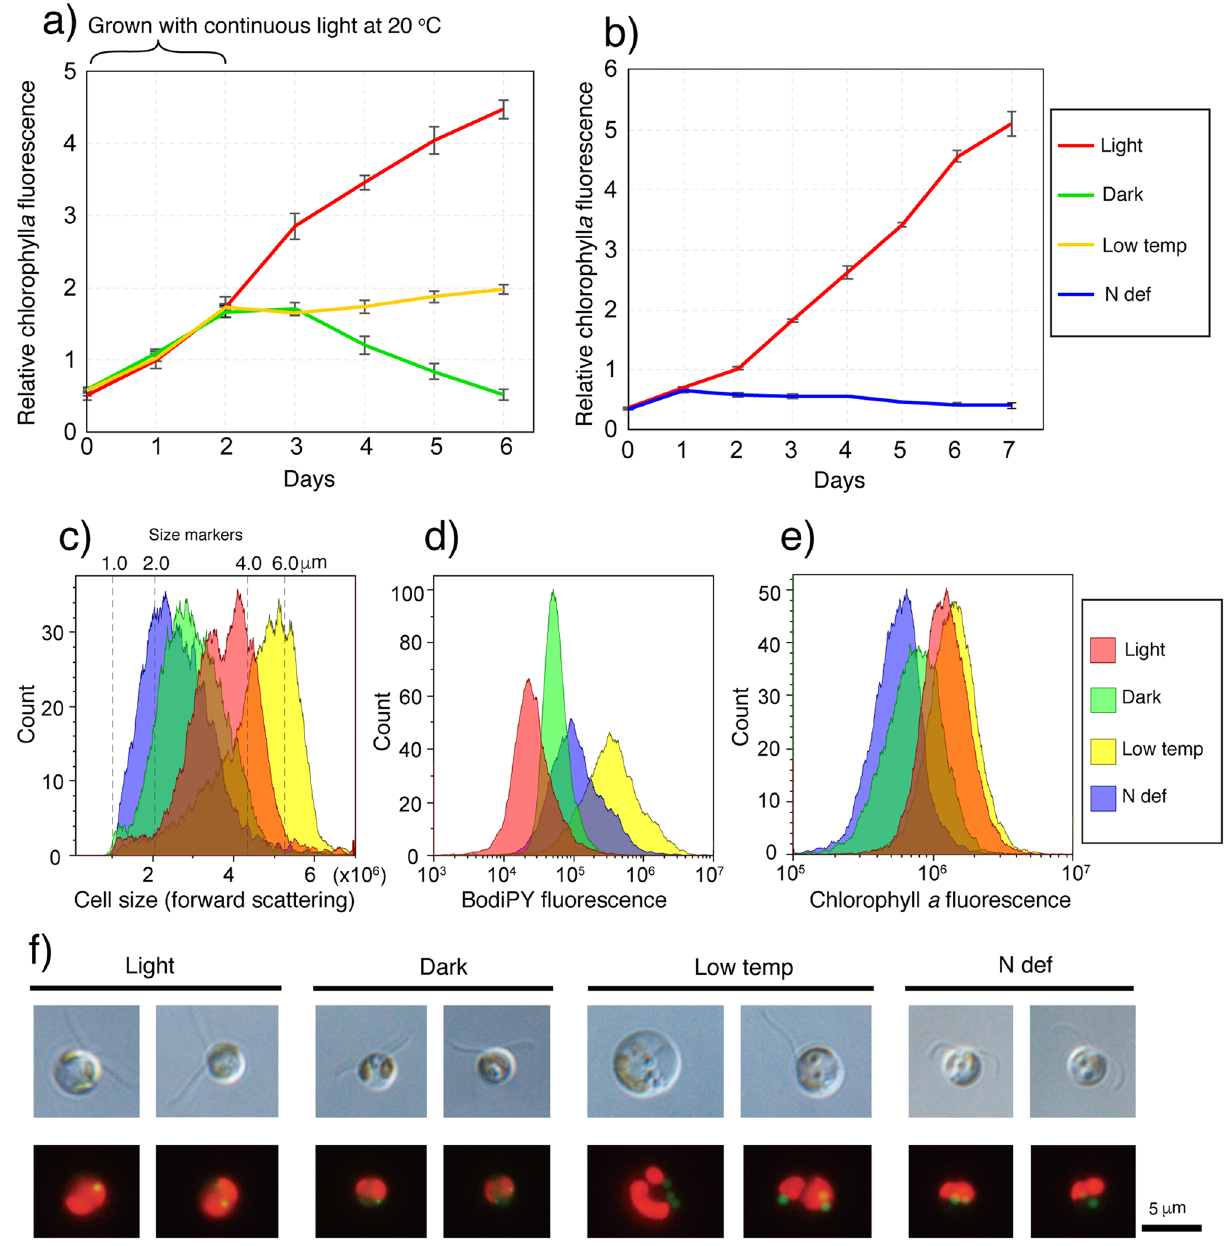
Figure 4. Effects of growth conditions on cell size and fluorescence from BODIPY and Chl. a . ( a , b ) Fluorescence from Chl. a was monitored in the ARC1 strain grown under four different culture conditions: continuous light at 20 °C (red); continuous dark at 20 °C (green); continuous light at 4 °C (yellow); and continuous light under nitrogen-deficient conditions at 20 °C (blue). Error bars indicate standard deviations of triplicate experiments. ( c–e) Flow cytometer analysis of cell size ( c ), and intensity of BODIPY ( d ) and Chl. a ( e ) fluorescence of the ARC1 strain. ( f) Light (upper) and fluorescence (lower) microscopic observations of the ARC1 strain under four different growth conditions. Red and green fluorescence from Chl. a and BODIPY, respectively were detected under blue light condition, 65.9 ng/mg for low-temperature condition, and 209 ng/mg for nitrogen-deficient condition (Sup- plementary Table S1). The range of the total n -alkane content of the ARC1 strain per dry cell weight under the four different conditions (0.005–0.024%) was lower than those of 0.02–2.9% previously reported for benthic and soil algae 10,18 . The total content of n -alkanes increased 5.6-fold (Dunnett’s test; p < 0.05) under dark condi- tion and 4.8-fold (Dunnett’s test; p < 0.05) under nitrogen-deficient condition compared with continuous-light conditions (Fig. 5a inset and Supplementary Table S1). The increases in most of the carbon numbers of n -alkanes were significant (Dunnett’s test; p < 0.05) (Fig. 5a, filled boxes). The total n -alkane content was 1.5-fold larger under low-temperature conditions than under continuous-light conditions, but the difference was not signifi- cant (Fig. 5a, inset). These results demonstrate that the n -alkanes of the ARC1 strain accumulated under dark